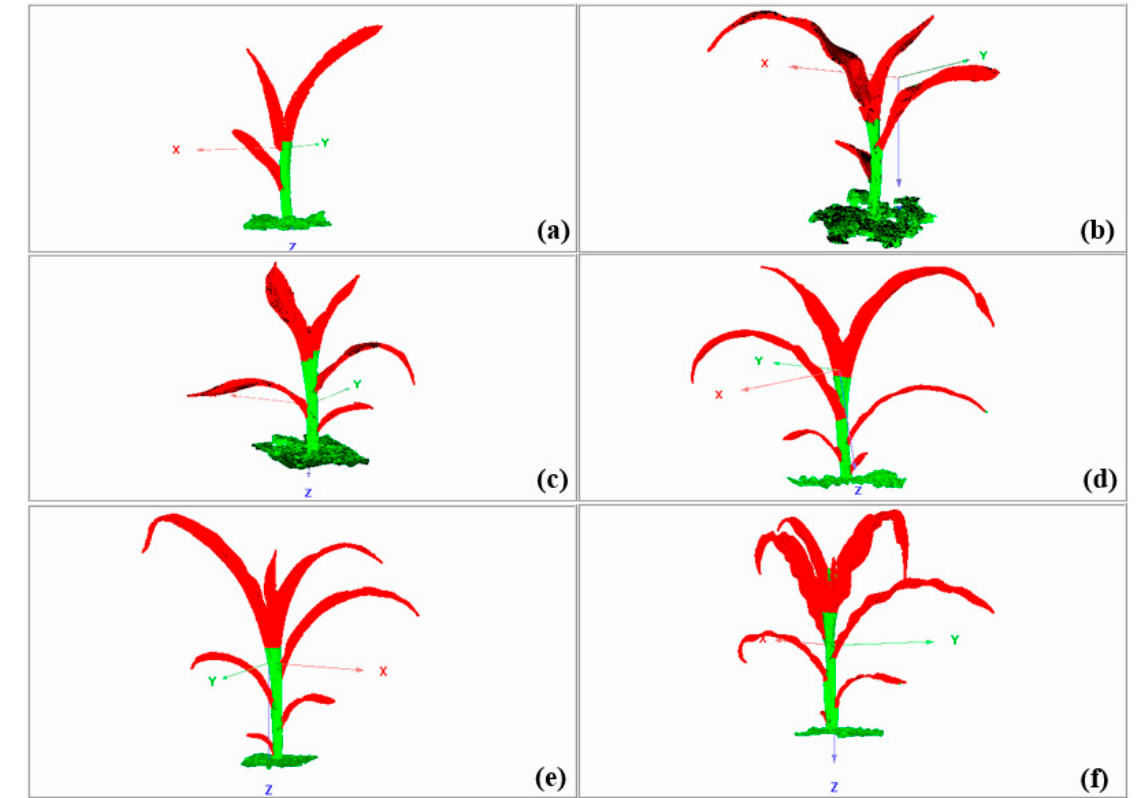
Figure 8. Raw 3D data of maize from the trefoil stage to the jointing stage. ( a ) A maize plant at the trefoil stage; maize plants at the jointing stage, including ( b ) a maize plant with 4 leaves, ( c ) a maize plant with 5 leaves, ( d ) a maize plant with 6 leaves, ( e ) a maize plant with 7 leaves, and ( f ) a maize plant with 8 leaves.